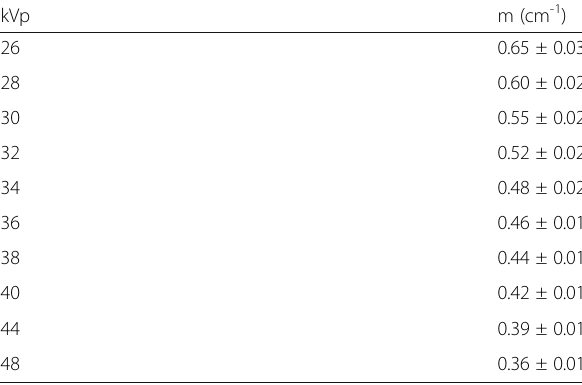
Table 3 Estimation of the m values for different tube voltage values